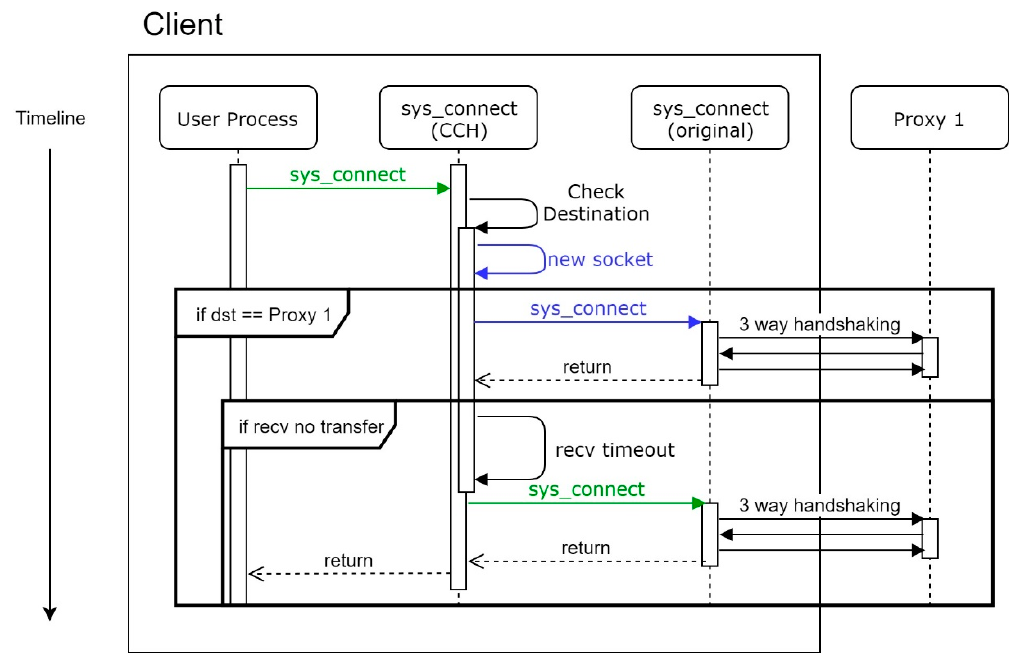
Figure 7. Workflow of CCH under a normal situation.